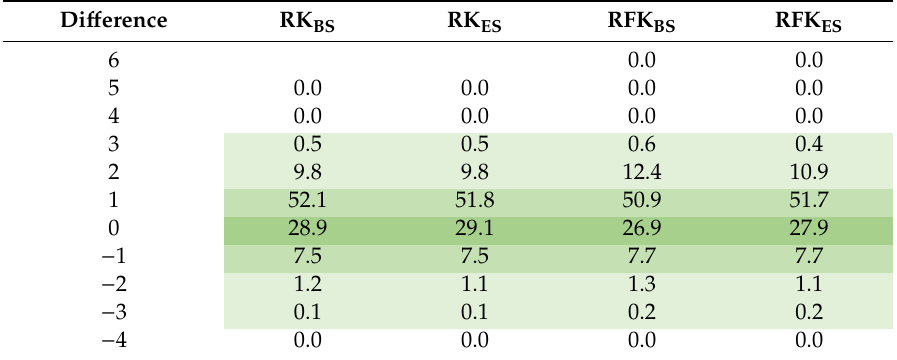
Table 3. Difference between the legacy map’s inundation frequency and the categorized inundation result maps expressed in percentage.